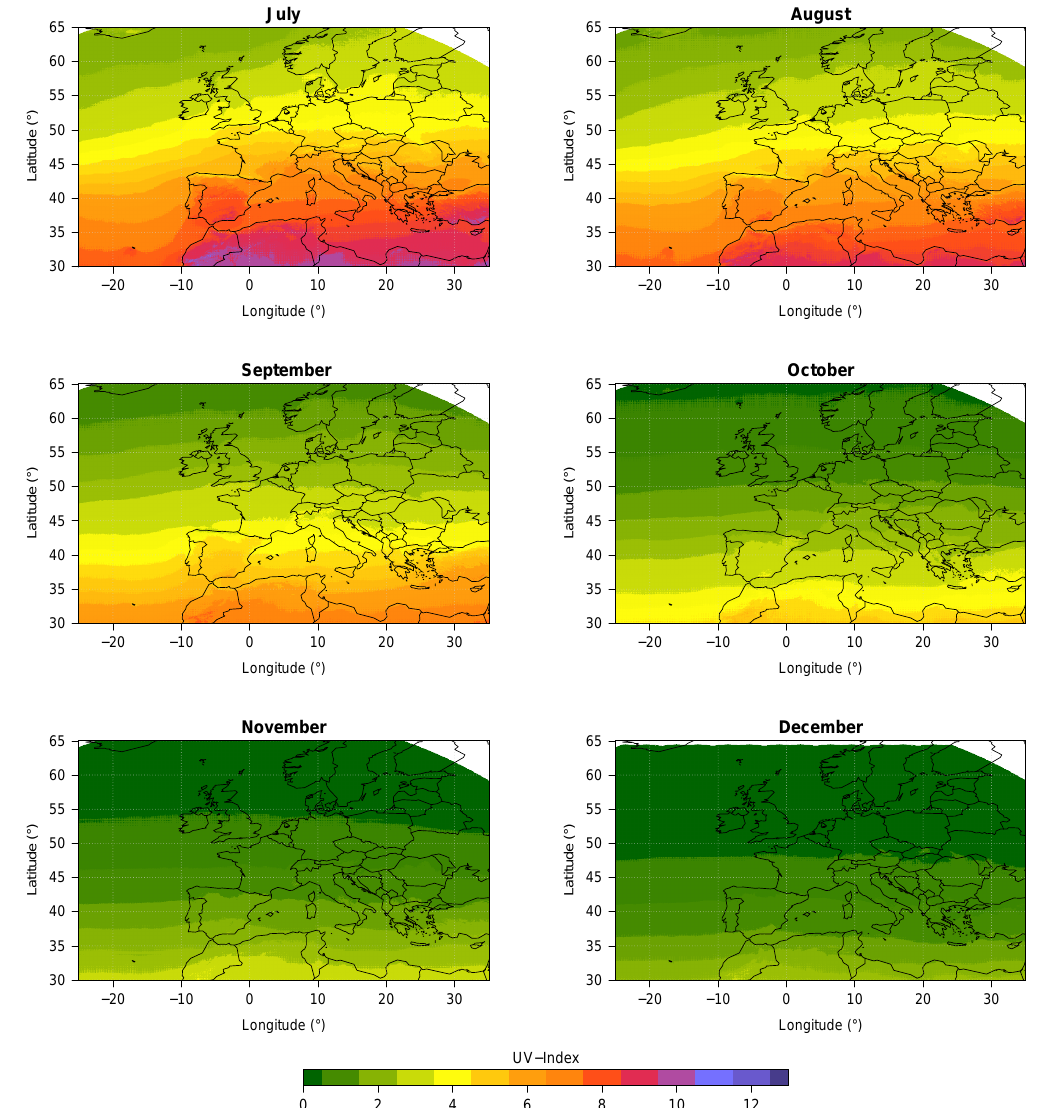
Figure 4. Monthly mean UVI at the local noon over Europe for July until December over the time period 1983–2015 based on satellite